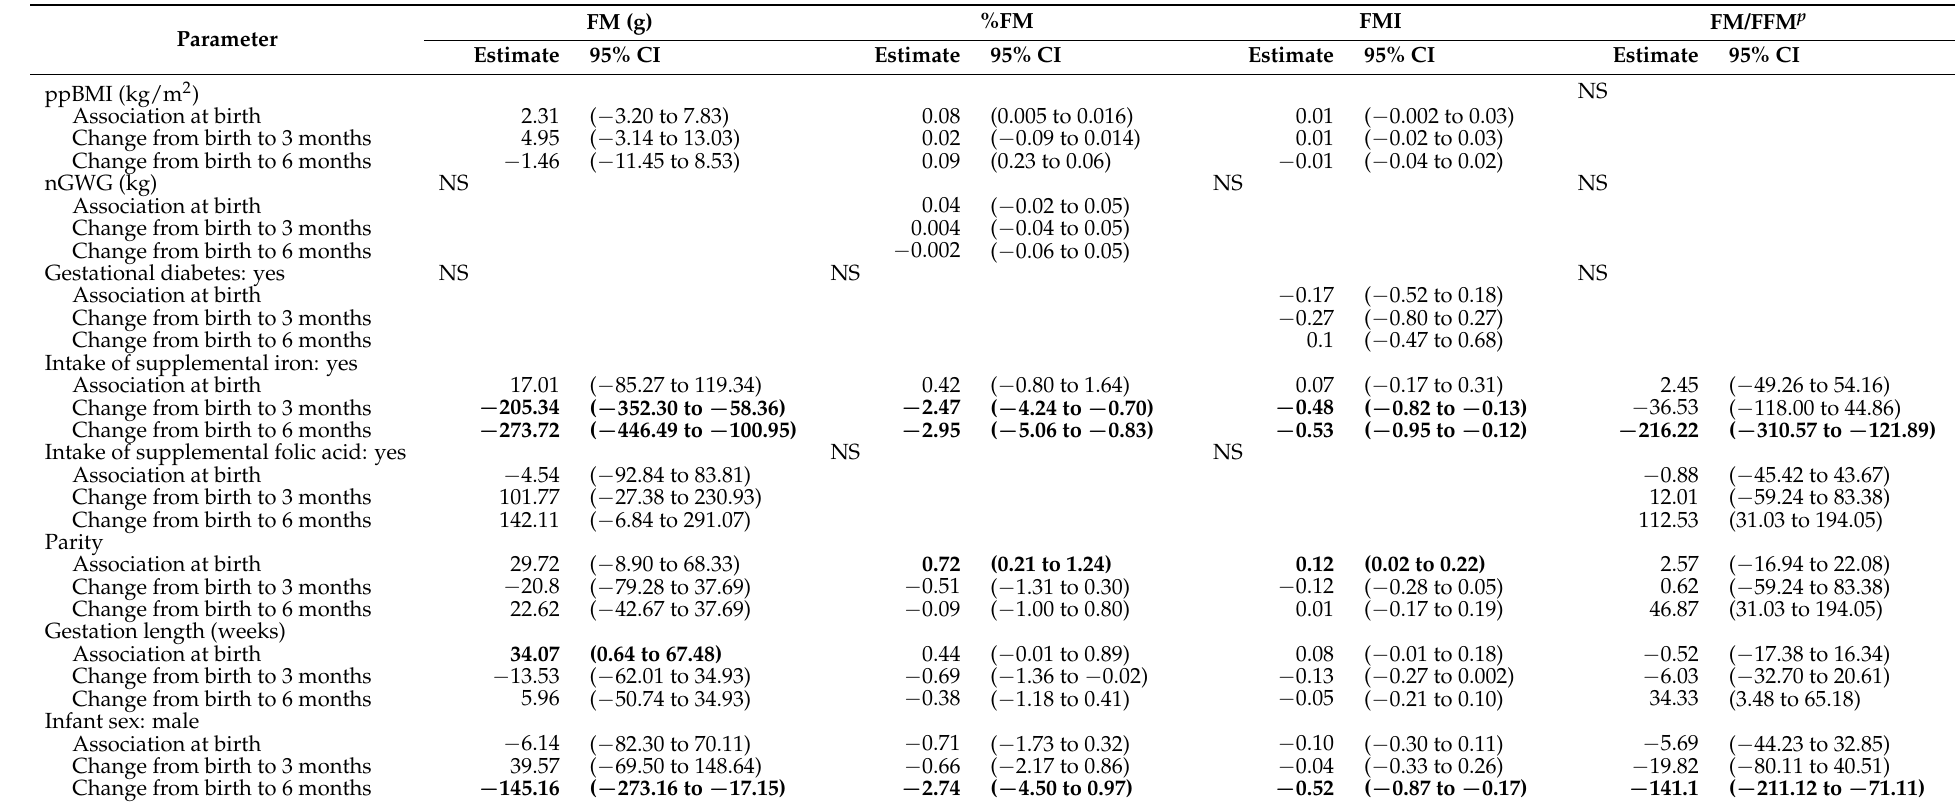
Table 3. Longitudinal associations between pre-pregnancy and prenatal factors and indices of infant adiposity from birth to 6